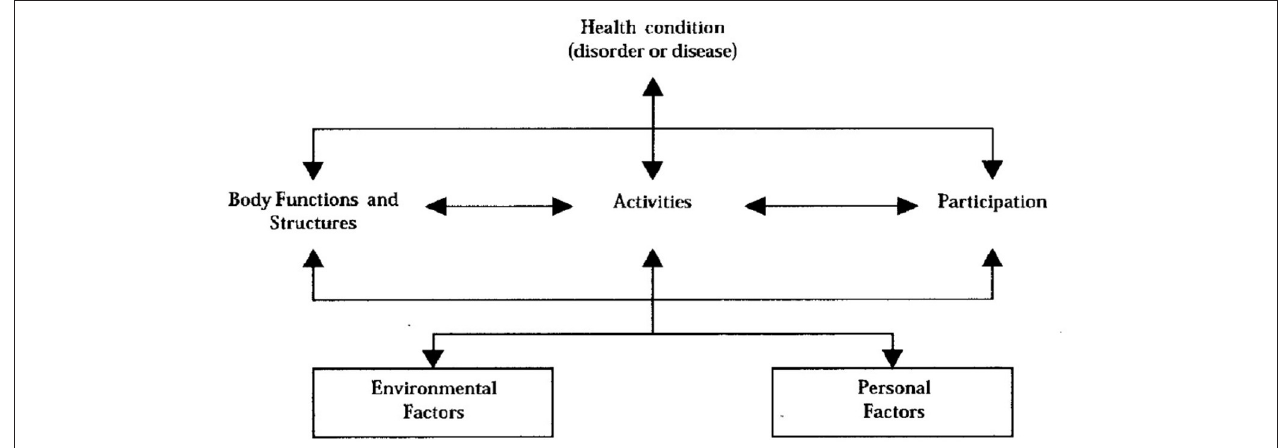
FIGURE 1 | Representation of the International Classification of Functioning, Disability, and Health (29).